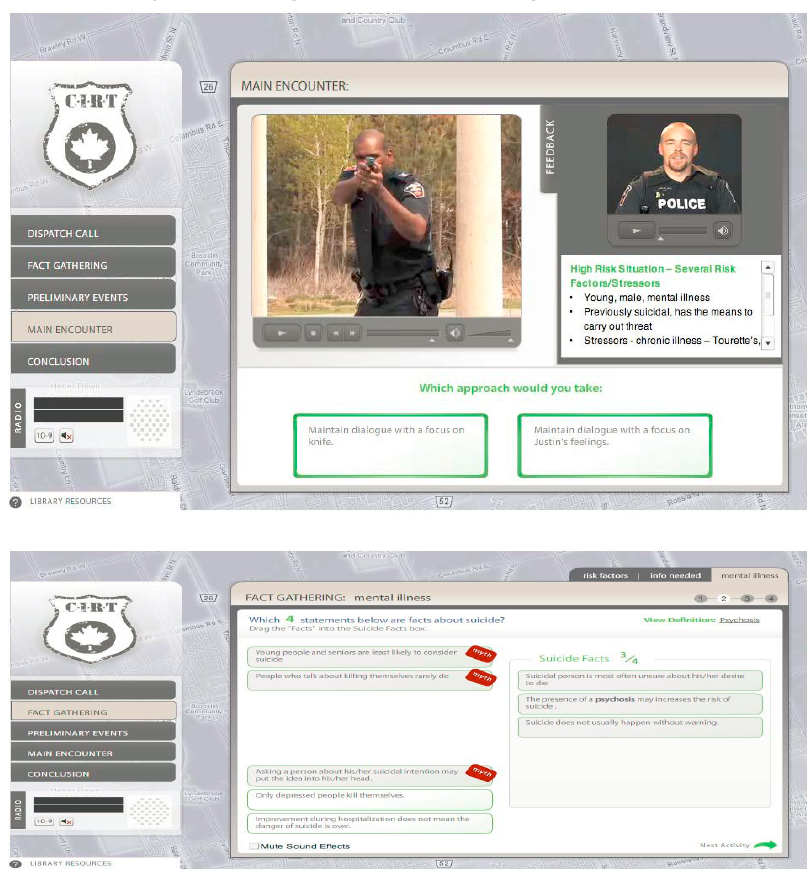
Figure 1: Example of an interactive video clip and feedback box in the simulation depicting suicidal behaviour